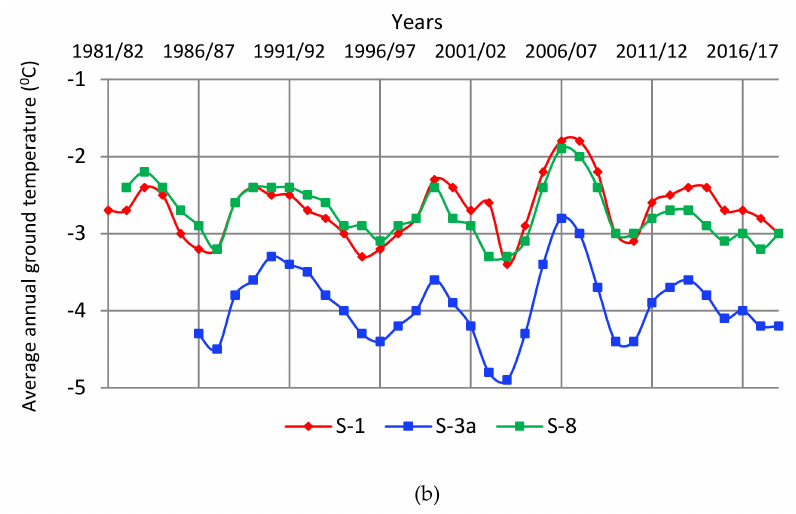
Figure 5. Long-term variability of ground temperatures at the base of the active layer ( a ) and at a depth of 10 m ( b ) in the shallow-valley type of terrain at the Chabyda station.